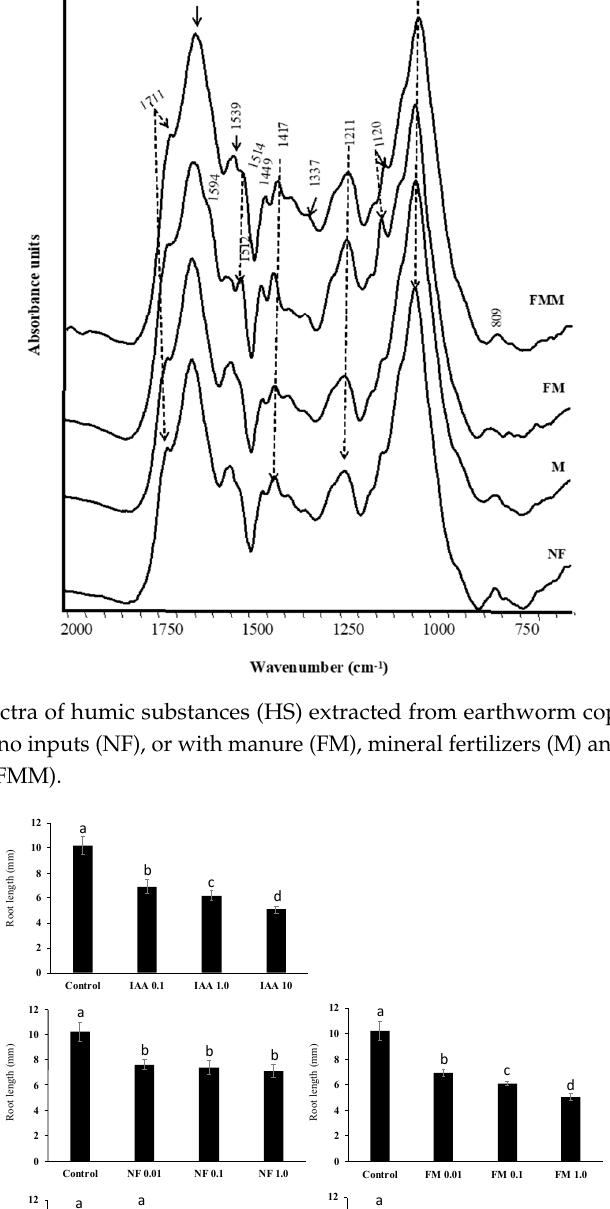
Figure 3. Auxin-like activity of HS from earthworm coprolites collected in soils fertilized with no inputs (NF), manure (FM), mineral fertilizers (M) or manure plus mineral fertilizers (FMM). Data represent the means of three measurements with ten plants in each. Values above bars following the same letter are not statistically di ff erent at p < 0.05 according to Student-Newman-Keuls